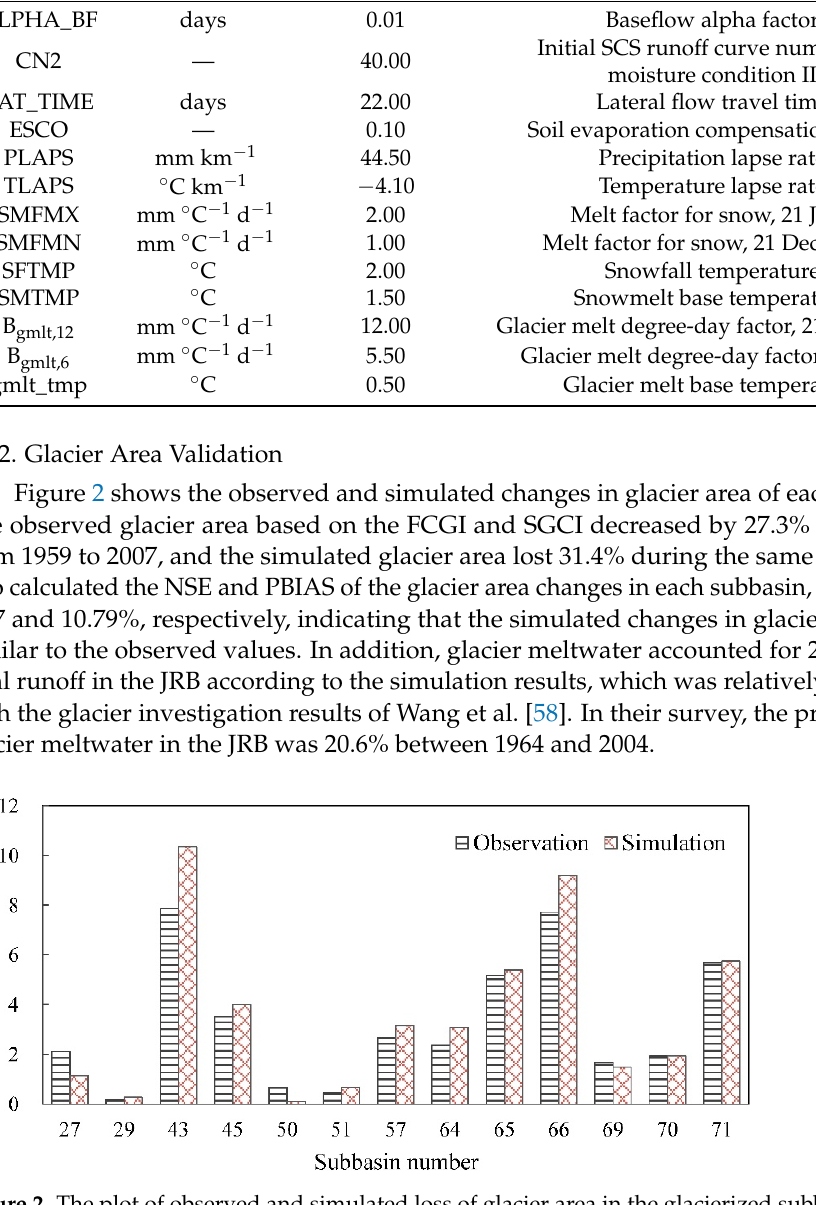
Figure 2. The plot of observed and simulated loss of glacier area in the glacierized subbasins.